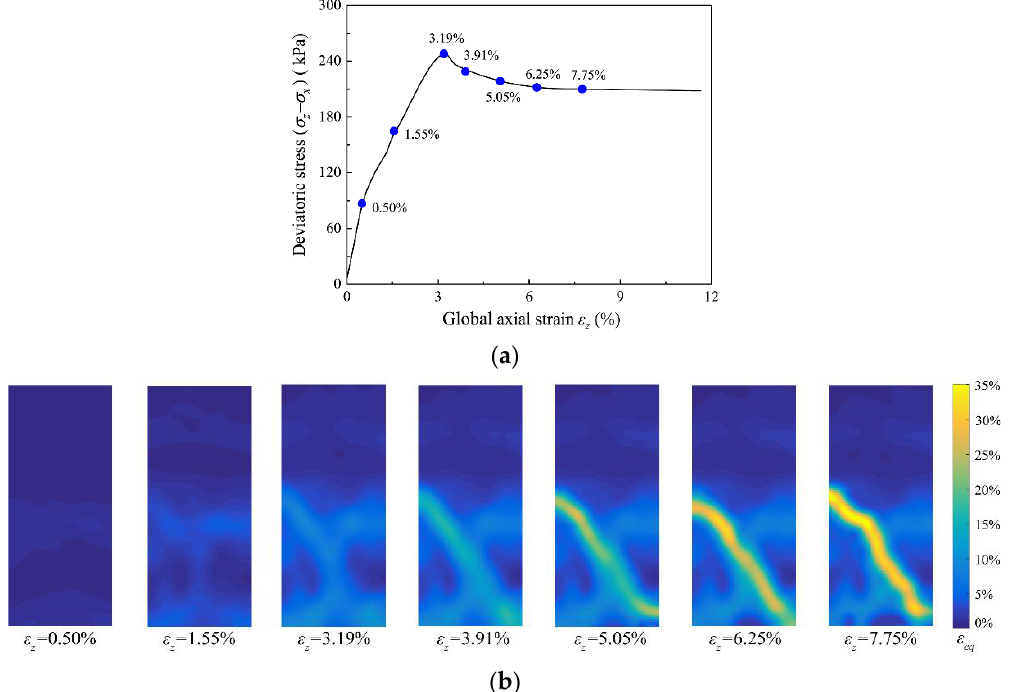
Figure 8. Results of DIC analyses for the T3 test: ( a ) global stress – strain relationship for the T3 test; ( b ) shear strain distribution at different stages in the T3 test.